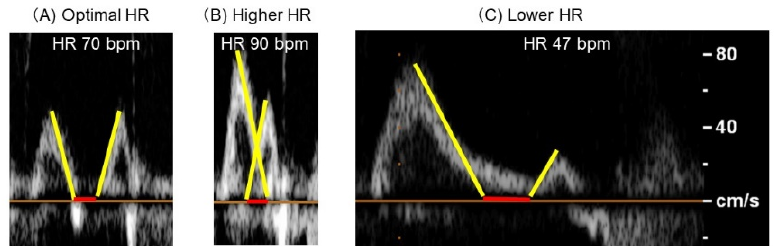
Figure 1. Examples of the overlap between E-wave and A-wave observed in Doppler trans-mitral echocardiographic flow. In a patient with optimal HR (HR difference ≤ ± 10 bpm), E-wave and A-wave almost stand adjacent without any overlap ( A ). In a patient with higher HR (HR difference > 10 bpm), 2 waves stand overlapped ( B ). In a patient with lower HR (HR difference < − 10 bpm), 2 weaves stand apart ( C ). HR; heart